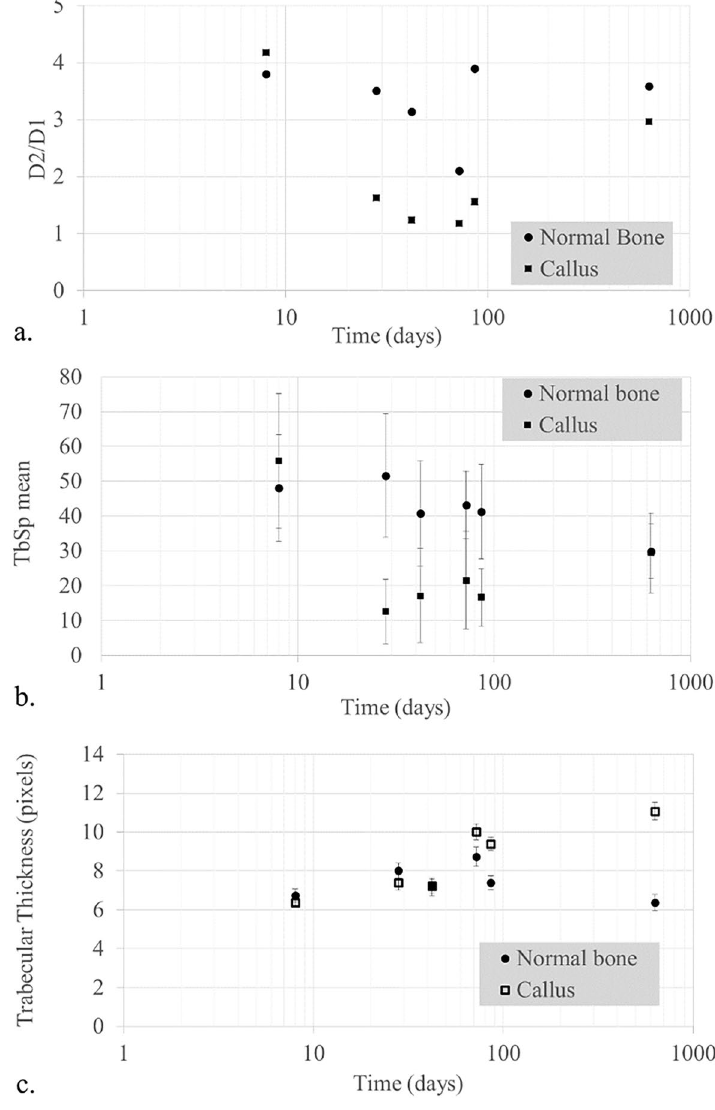
Figure 2. Degree of anisotropy ( a ), trabecular separation ( b ) and trabecular thickness ( c ), ( a ): ratio between the medium (D2) and the shorter ellipsoid axis (D1) in order to test the degree of anisotropy in the transverse plane of the rib both in the callus and in areas distant from it ; ( b ): ratio of the mean value of the trabecular separation (TbSp) and its standard deviation both in the callus and in areas distant from it; ( c ): time-evolution of trabecular thickness of the callus and the normal bone away from the fracture. Values for N2 were averaged. Graph realized with Microsoft